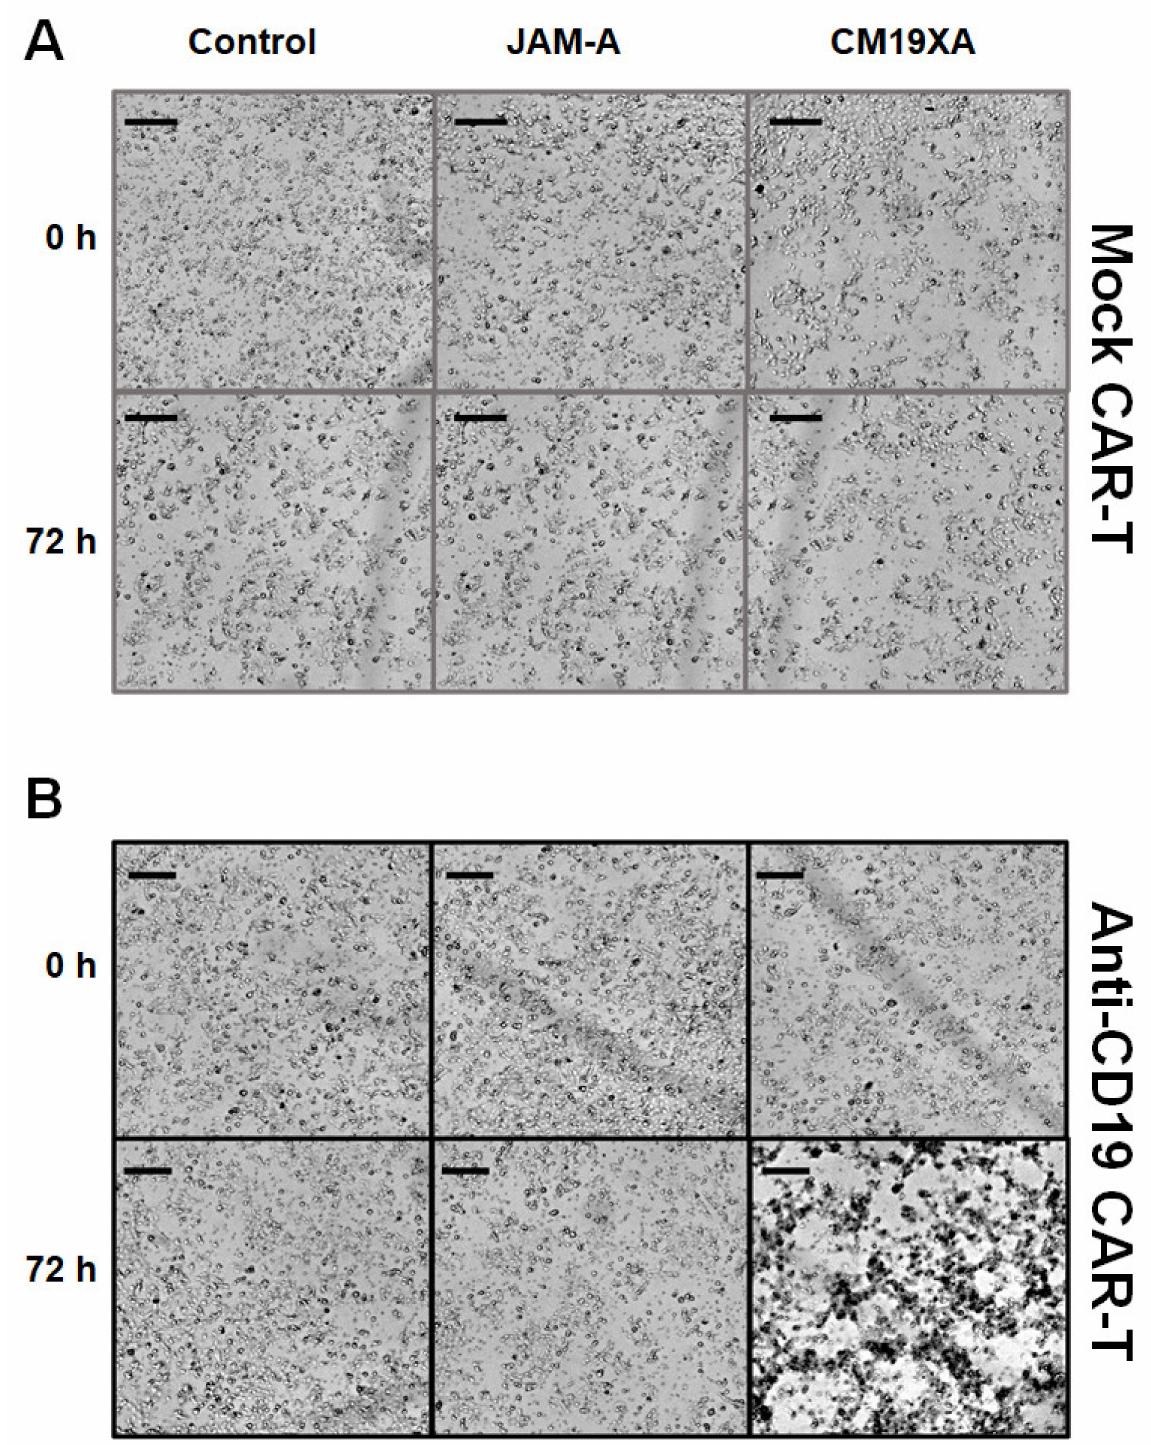
Figure 6. Cytotoxicity assay. Images of CAL27 cells at 0 and 72 h post protein treatment. Cells were incubated with either mock or CD19 CAR-T with a ratio of 1:5 (CAL27: CAR-T). ( A ) There was no killing observed in mock CAR-T (CAR-T not able to recognize CD19) with the control (no protein), JAM-A, and CM19XA. ( B ) Anti-CD19 CAR-T cells had no killing from 0 to 72 h in the presence of the control or JAM-A. There was an increase in target killing of CAL27 cells in the presence of CM19XA, suggesting that the extracellular CD19 in the biologic can work as a recognition site for anti-CD19 CAR-T cells. Scale bar is 100 µ